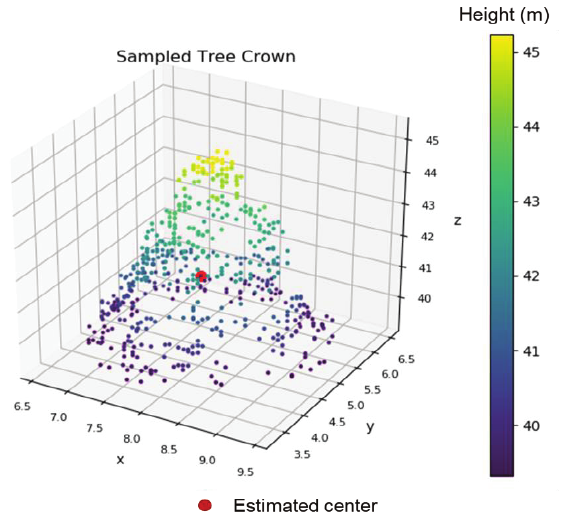
Figure 3. The sampled tree crown with extracted the keypoint (red circle)